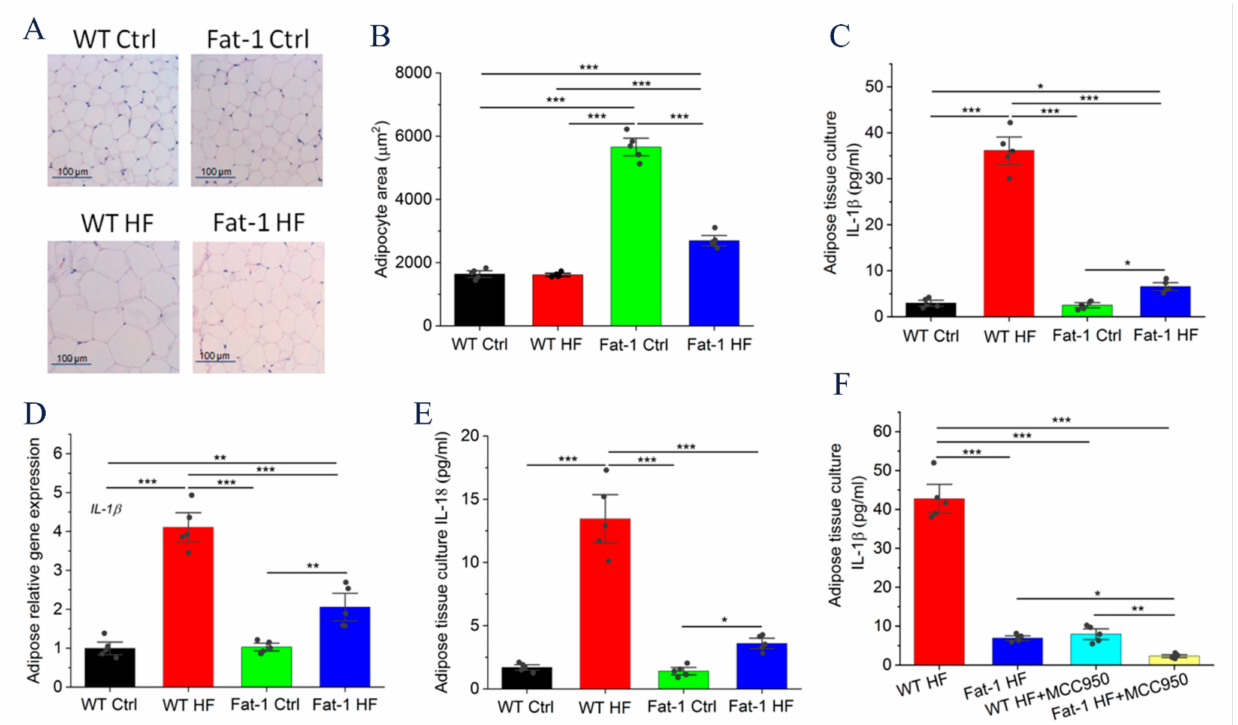
Figure 2. Endogenous n-3 PUFA suppressed HF diet-induced IL-1 β and IL-18 secretion in adipose tissue: ( A ) Adipocyte size was monitored in adipose tissue samples by hematoxylin-eosin